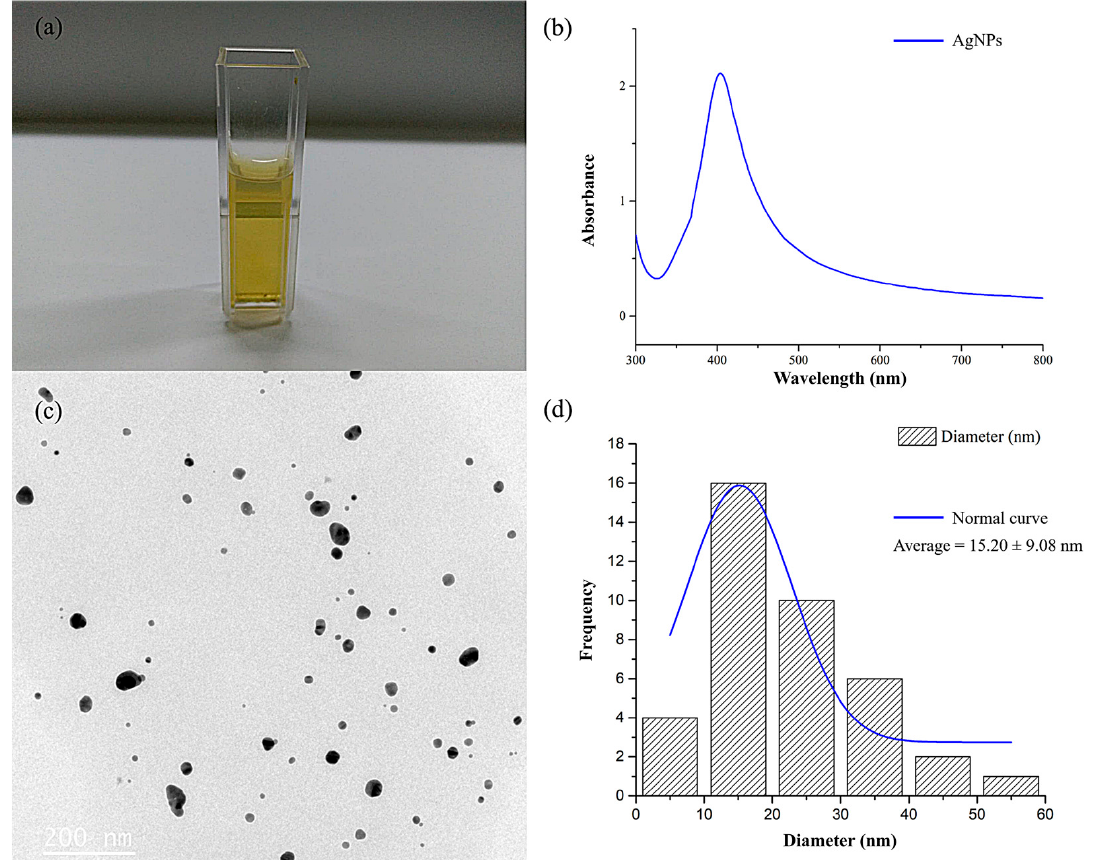
Figure 1. Physicochemical characteristics of the AgNPs: ( a ) AgNP solution; ( b ) UV–Vis spectrum absorption of the AgNPs; ( c ) TEM image of the AgNPs; and ( d ) size distribution of the AgNPs based on a TEM image.